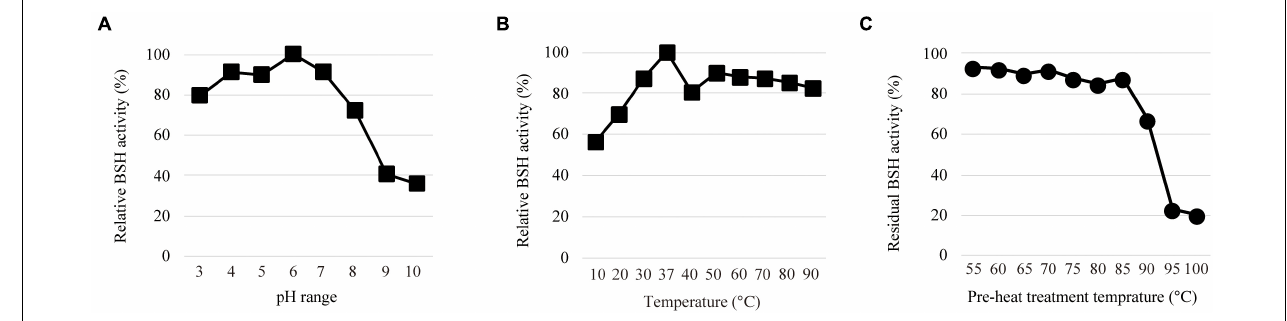
FIGURE 2 | Biochemical features of LapBSH. (A) The effect of pH (pH 3.0–pH 10.0), (B) temperature (10 ◦ –90 ◦ C), and (C) pre-heat treatment (55 ◦ –100 ◦ C) on BSH activity toward TDCA. Each value represents the mean of eight technical replicates ( n = 8). Maximum activity was recorded as 100%. Error bars indicate